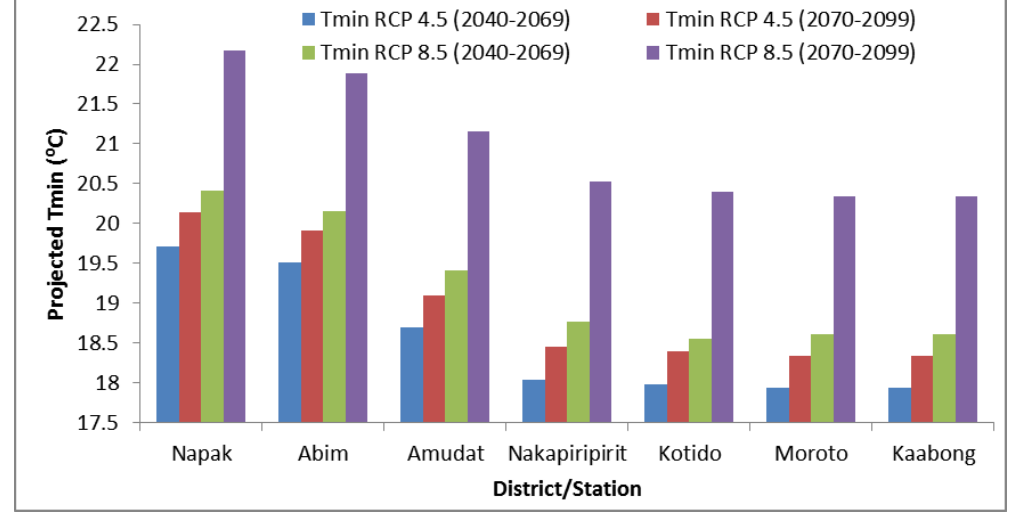
Figure 10. Projected minimum temperatures at district level in Karamoja.